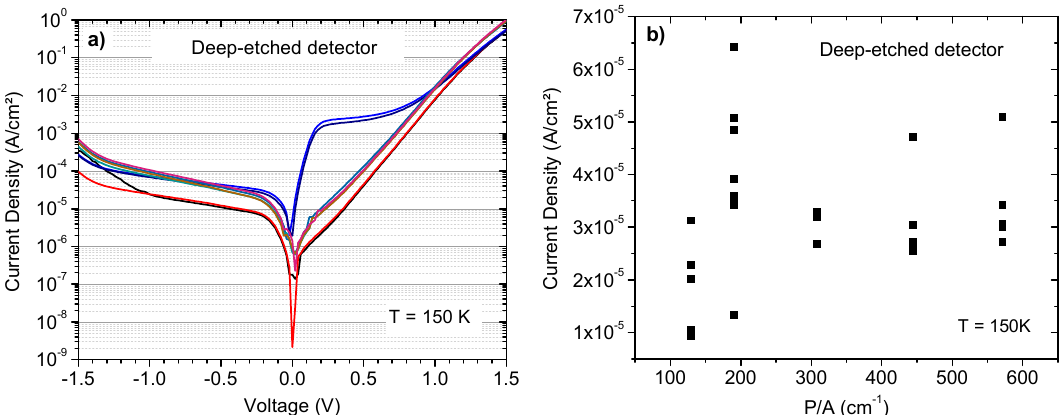
Figure 11. Deep-etched photodetectors: ( a ) dark current density voltage characteristics performed on different detector sizes at 150 K; ( b ) dark current density value as a function of the perimeter to area ratio, extracted at V = − 400 mV.